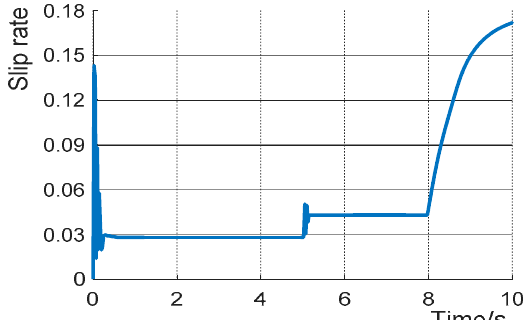
Figure 14. The actual slip rate curve.